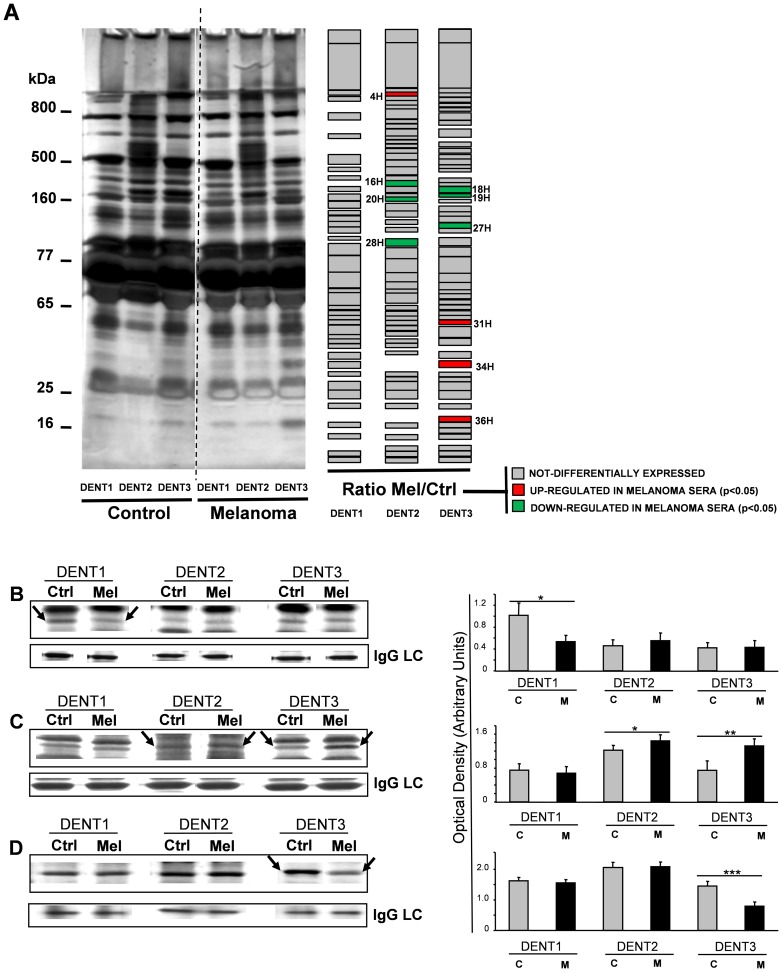
TRIDENT analysis of melanoma vs control sera.A: Silver staining of TRIDENT analysis of sera from melanoma patients and healthy subjects. The most significantly (p<0.05) modified bands, as assessed by densitometric quantification of 3 different experiments each of them carried out on human sera from 4 healthy and 4 melanoma affected individuals, are schematically highlighted as green (down-regulated in melanoma sera) or red (up-regulated in melanoma sera) boxes. Only 1 control subject and 1 melanoma patients are shown. B, C, D panels: Silver staining of three different bands whose expression resulted modulated in control (Ctrl) vs melanoma (Mel) mice sera. Statistical analysis was performed on groups of 6 mice per treatment. The reported bands, marked by arrows, are those found significantly differently expressed in cancer sera compared to controls, in at least 3 independent experiments. B: Band M21 (Complement factor B) is down-regulated in sera from melanoma affected mice, in DENT1 condition, compared to the control (* = p<0.0476). C: Band M32 (Apo E) is up- regulated in sera from melanoma affected mice compared to the control, both in DENT2 (* = p<0.04083) and in DENT3 condition (** = p<0.0056). D: Band M15 (α2Macroglobulin) is down- regulated in sera from melanoma affected mice in DENT3 condition, compared to the control (*** = p<0.0074).